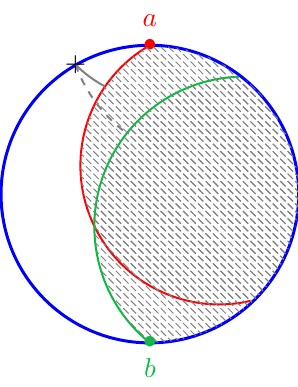
Figure 7 . A constant time slice of the point particle (defect) bulk geometry eq. (4.7) in the untwisted radial and angular coordinates ( r, θ ) with two Karch-Randall branes. The blue circle is the bulk conformal boundary. The two conformal boundaries a and b of the branes (in red and green) are separated by π in the coordinate θ ( θ = 0 and θ = π ). The black cross is an example a b bipartition point on the boundary with two Ryu-Takayanagi surfaces ending on the branes. The physical RT surface (solid) has always a smaller area than the unphysical one (dashed) ending on the “hidden” part of the